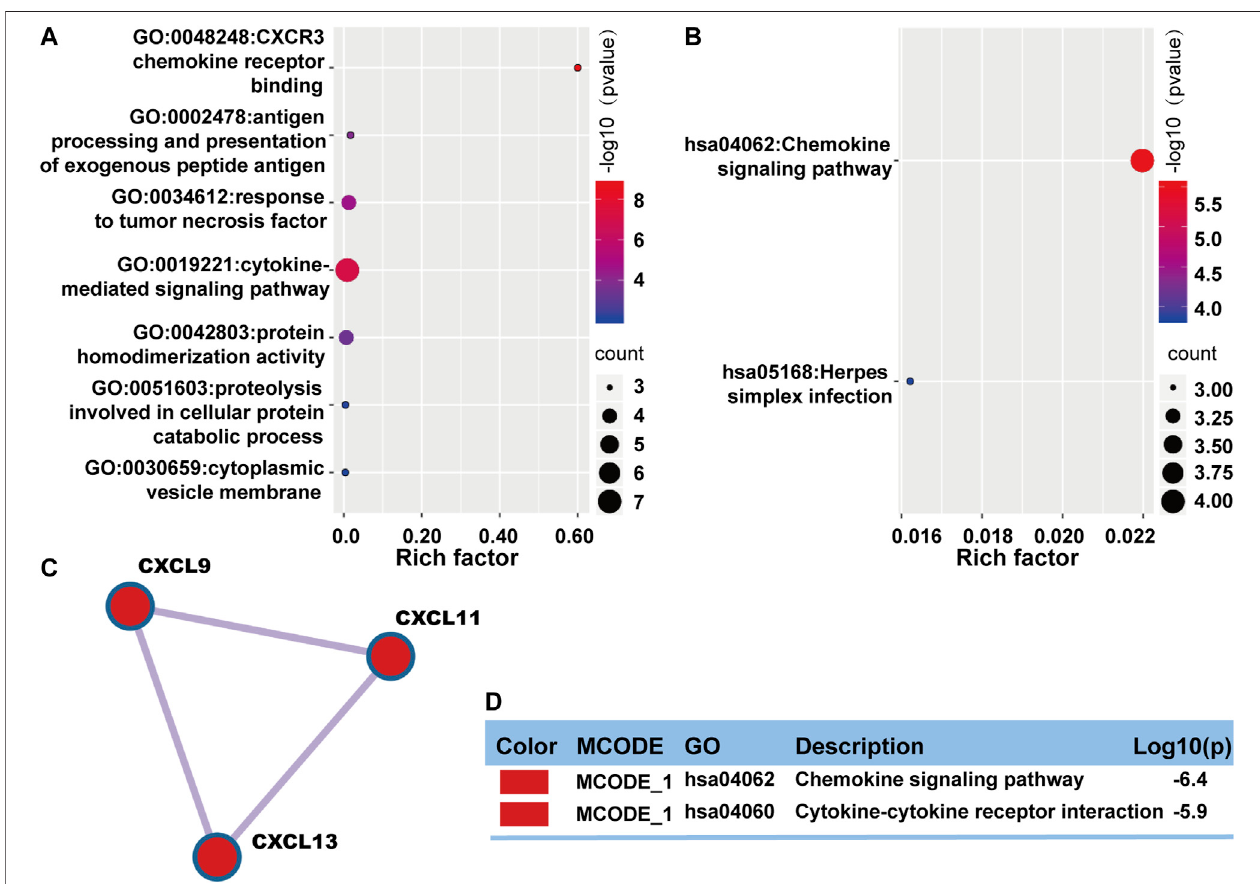
FIGURE 6 | Functional enrichment of common DEGs with prognostic value in OV. (A) A bubble plot displaying GO enrichment analysis. The enriched terms were colored by p -value, which contained more genes that leaned towards having a larger bubble. (B) A bubble plot describing KEGG enrichment analysis. The enriched terms were colored by p -value, which contained more genes that leaned towards having a larger bubble. (C) One MCODE was formed in the protein-protein interaction network. (D) The MCODE was described by functional enrichment analysis.